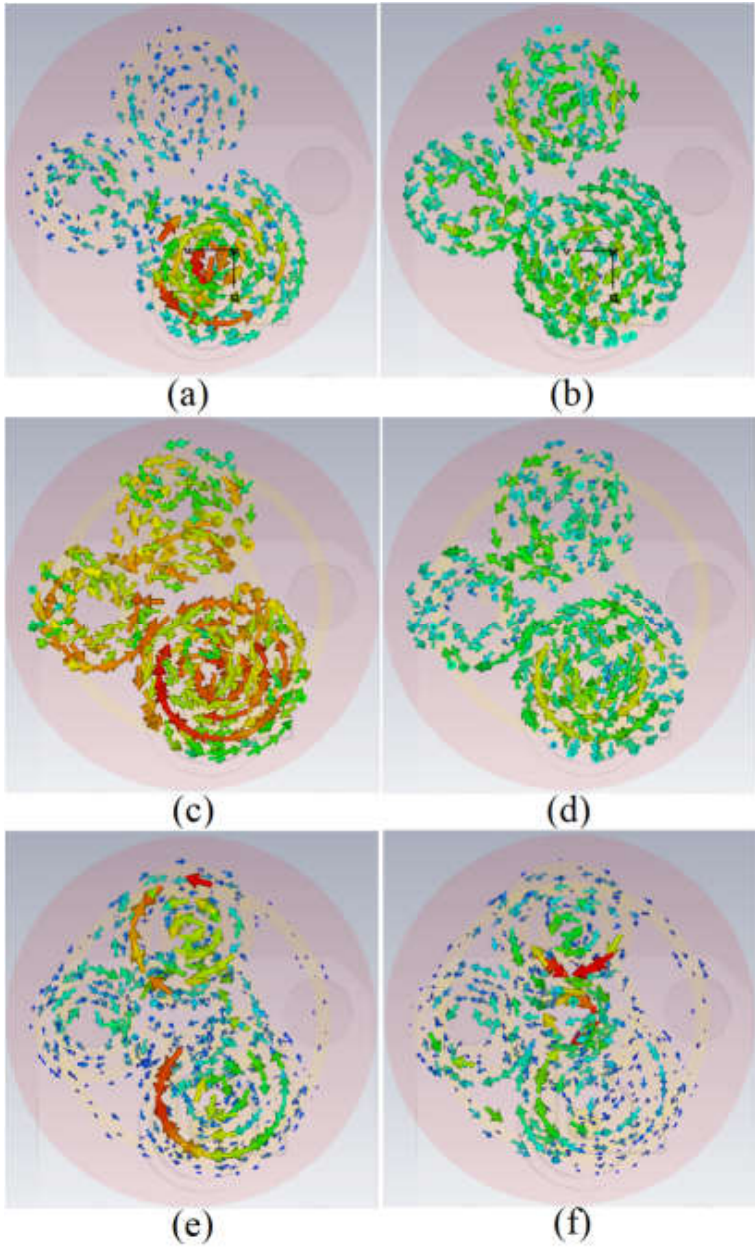
Figure 3. The surface current distribution of the button spiral antenna ( a , b ): no loadings at 3.4 GHz and 5.6 GHz; ( c , d ): after adding three rings at 3.4 GHz and 5.6 GHz; ( e , f ): after adding vias at 3.4 GHz and 5.6 GHz).